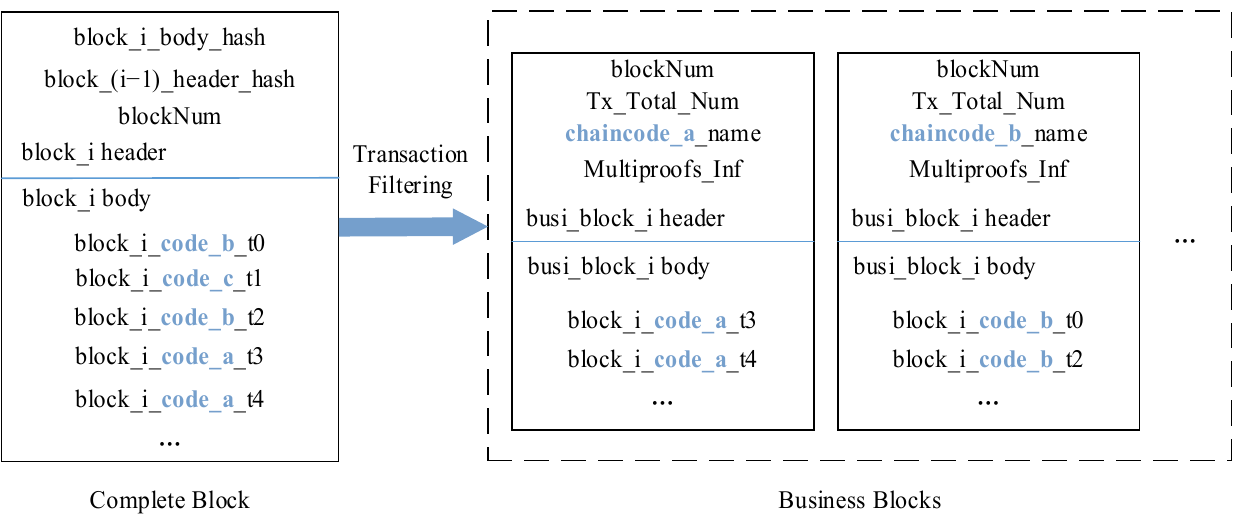
Figure 4. Business block generation.